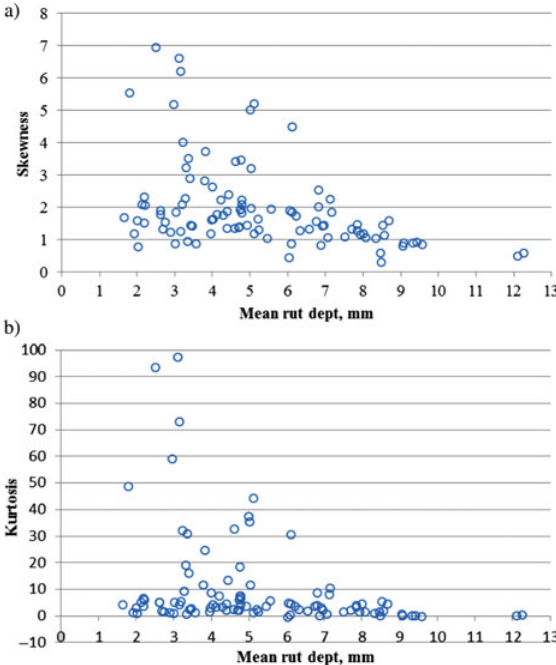
Fig. 3. The impact of average rut depth h m on its individual sections of the proximity of depth distribution (compliance with normal distribution) in terms of: a (cid:3) skewness; b